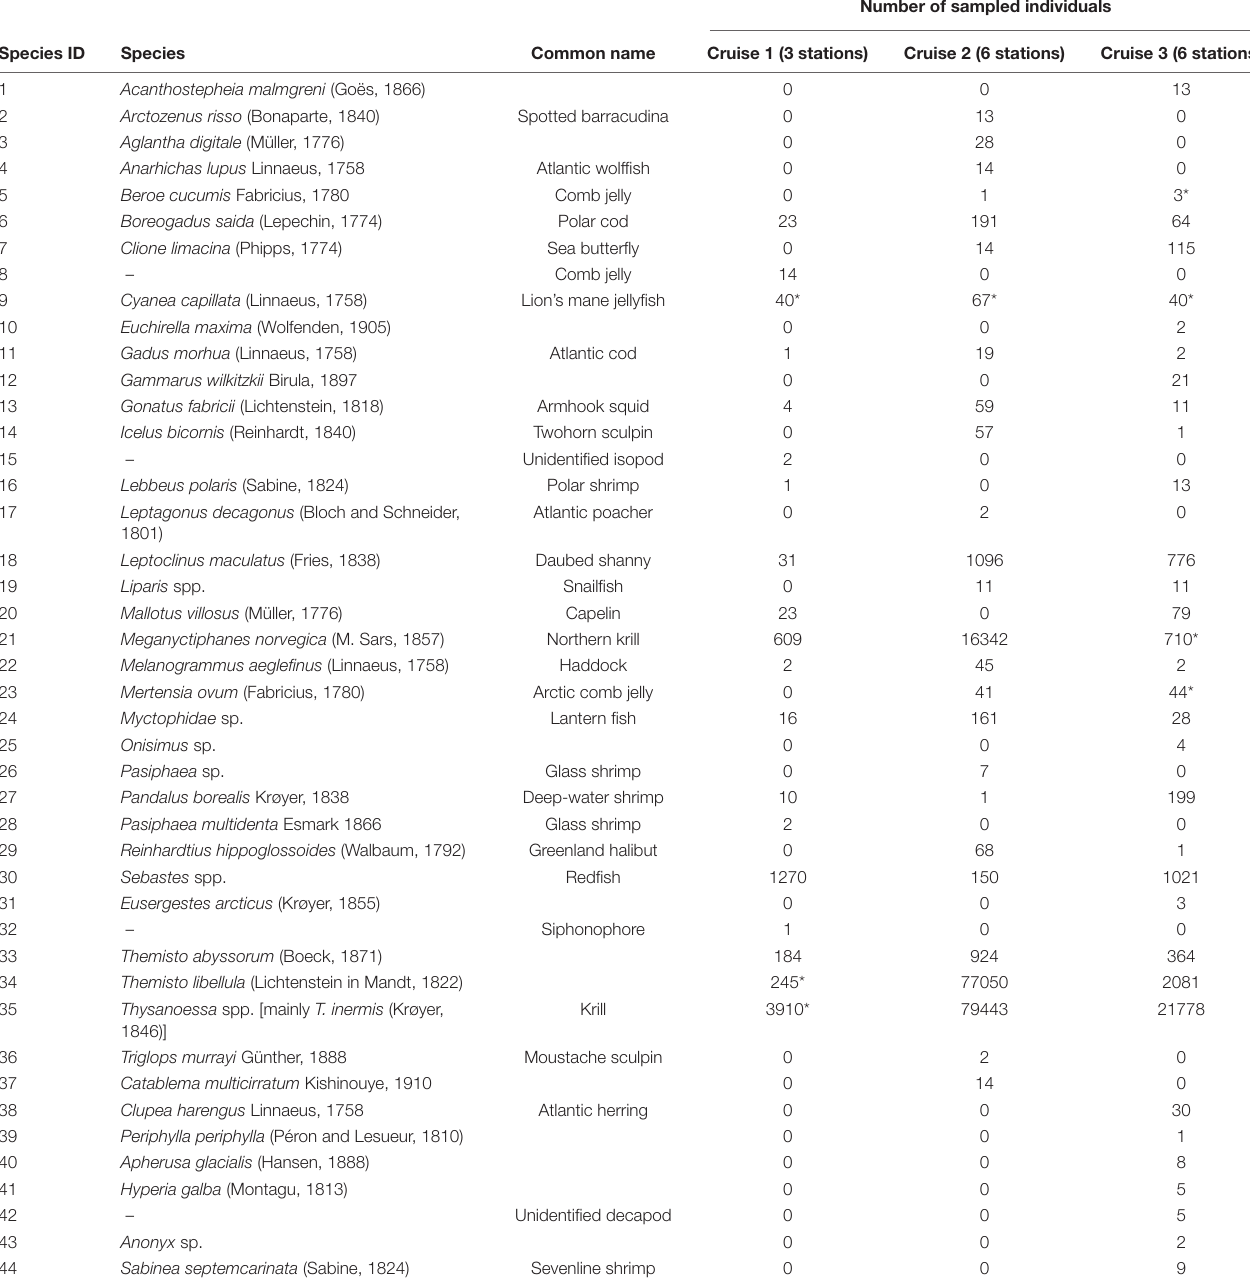
TABLE 1 | List of species and number of individuals sampled during the three experiments.